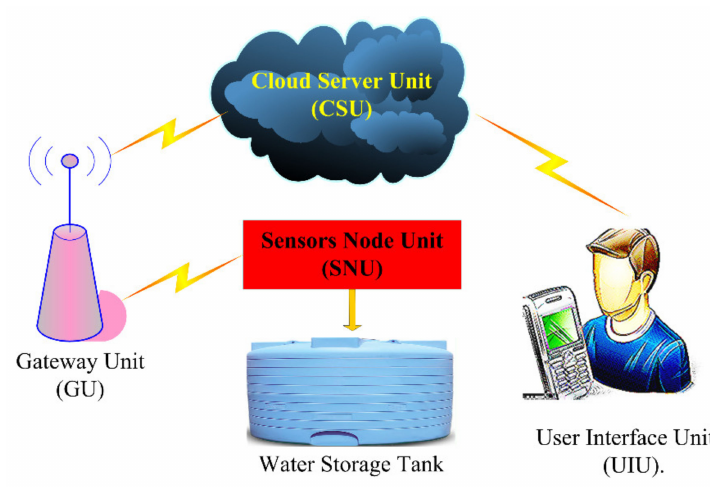
Figure 2. A typical diagram of